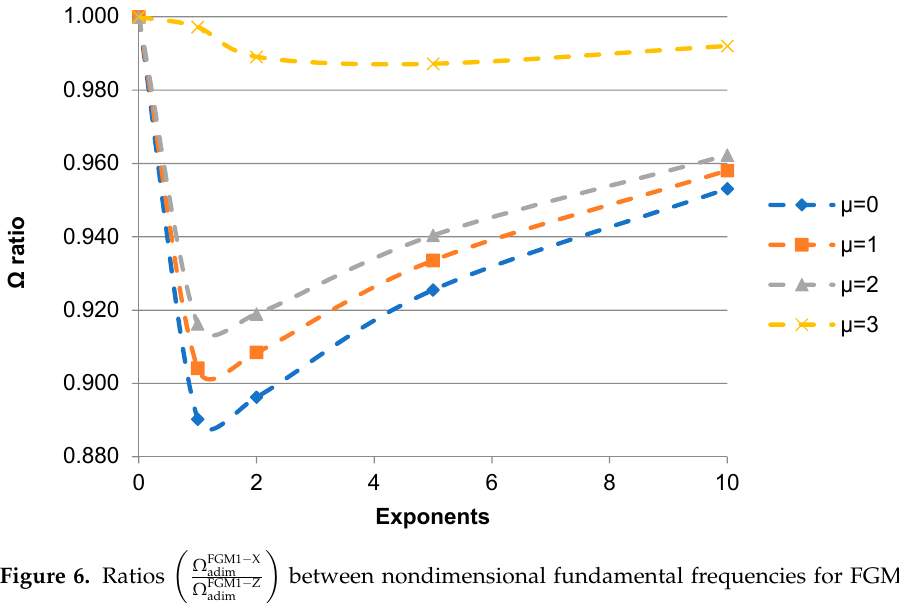
Figure 6 depicts the curves for the ratios (cid:3436) the nondimensional fundamental frequencies of FGM1-X and FGM1-Z beams for different Figure 5. FGM1-Z nondimensional frequencies ( Ω (cid:2911)(cid:2914)(cid:2919)(cid:2923) ) for different vibration modes. L/h = 10. Figure 5. FGM1-Z nondimensional frequencies ( Ω adim ) for different vibration modes. L/h = 10. exponent values.